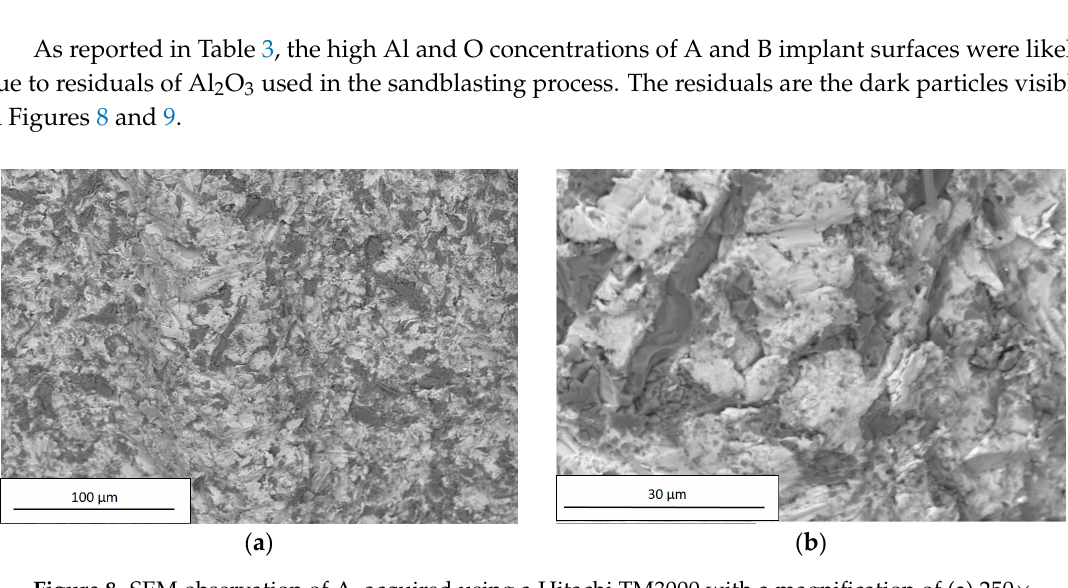
Figure 8. SEM observation of A, acquired using a Hitachi TM3000 with a magnification of ( a ) 250× and ( b ) 2500×.